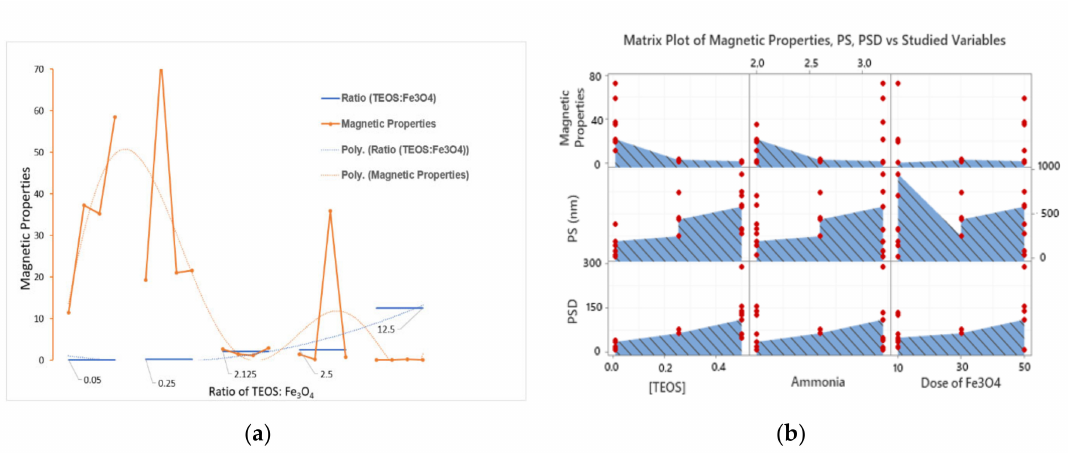
Figure 2. ( a ) Mapping of magnetic properties pattern as a function of the ratio of (TEOS):Fe 3 O 4 . Each of the shown ratios was obtained based on the setup shown in Table 2. Each ratio group has four points representing the four test tubes across the design setup sharing the same ratio of TEOS:Fe 3 O 4 . ( b ) A matrix plot for each of the three responses measured vs . the three numerical variables. In the same itinerary, the two-dimensional (2D) contour plots as well as surface plots (3D) were instigated to investigate the relationship between the magnetic properties on the z- axis (measured as response surface), and the predictors ([TEOS] and PS, upper panel; and [TEOS] and yield (g), lower panel) on the x- and y- axes, respectively, Figure 3A-D. In general and as the [TEOS] and PS (nm) increases, the magnetic property decreases (lighter areas); however, at a certain [TEOS] of nearly 0.22–0.30 M and PS of 120–280 nm, magnetic property increases again. A similar ridge was observed in the 3D surface plot. In the lower panel, a similar observation would be confirmed for both [TEOS] and yield (g).